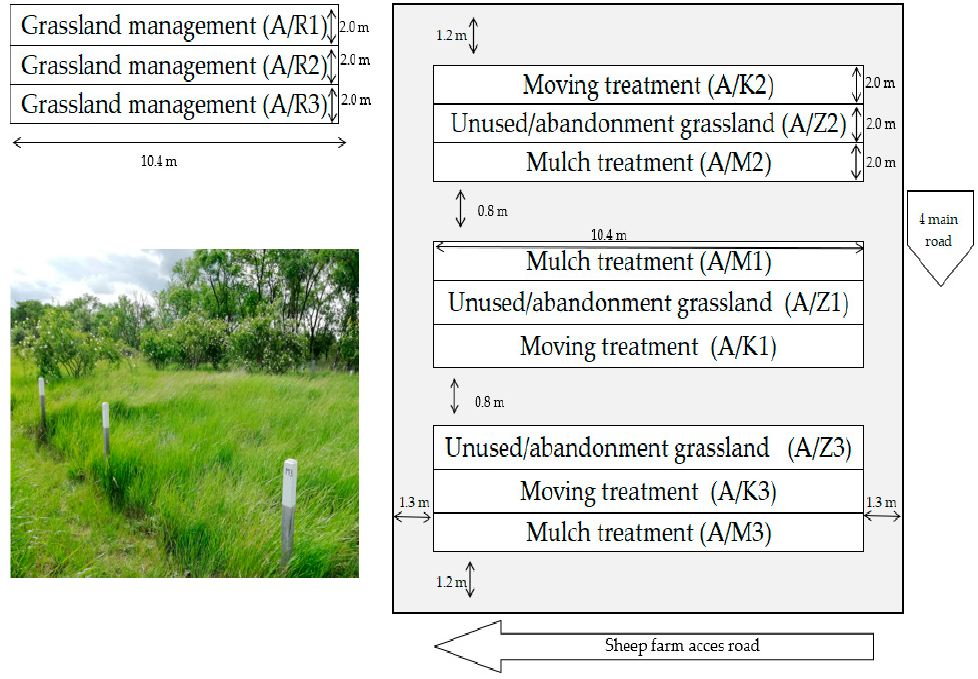
Figure 1. Plots and photo of the experiment set up in the underutilised area (Karcag, 2019–2020) (own editing and photo).